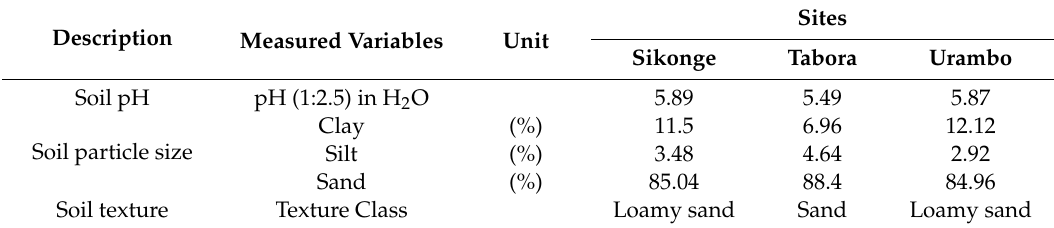
Table 1. Selected soil properties of experimental soils before tobacco